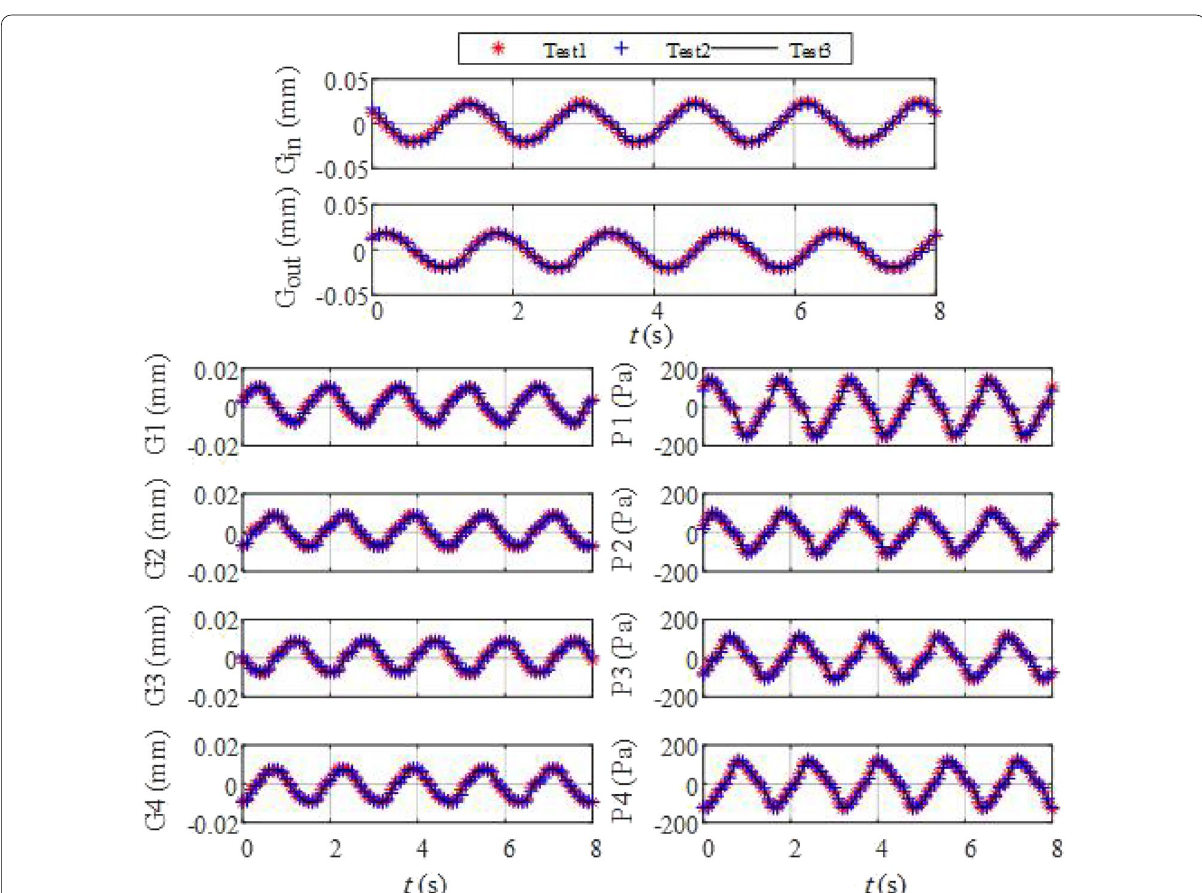
Figure 12 Sample time-series data of the experiment repeatability for a wave condition of H R i 1.34 =